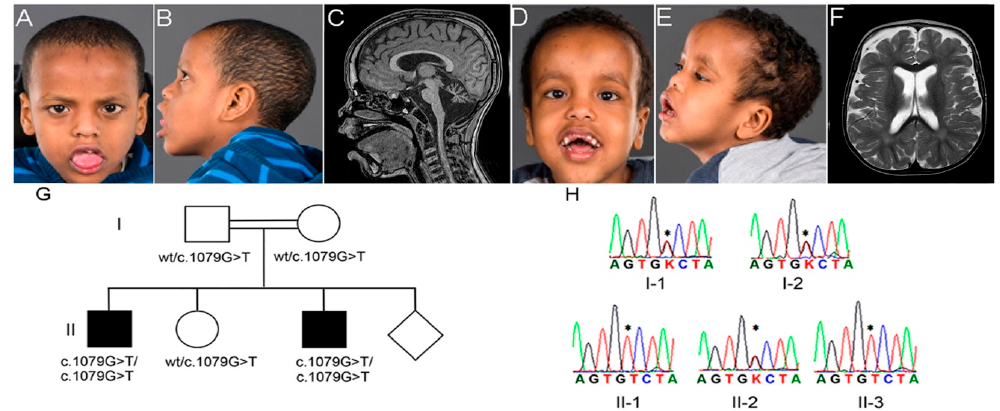
Figure 1. ( A , B ) Photographs of patient 1 taken at seven years; and ( C ) cerebral magnetic resonance imaging (MRI) with T1 sagittal midline-view of patient 1 at nine years; ( D , E ) Photographs of patient 2 taken at five years; and ( F ) MRI with T2 axial view at the level of centrum semiovale of patient 2 at 14 months; ( G ) Family pedigree with segregation of the PIGT c.1079G>T; and ( H ) chromatograms showing the Sanger sequencing of the PIGT c.1079G>T in the family members. Both patients had a high anterior hairline, a high and broad forehead with frontal bossing, bitemporal narrowing, a short nose with anteverted nares and a depressed nasal bridge, a short philtrum, a tented lip, and a wide, open mouth with sagging of the lower jaw, consistent with hypotonia. Note hyperplastic gingiva, widely spaced and irregularly shaped and sized teeth. Some teeth were missing due to falls ( D ); The ears were low-set in patient 2 ( D ). Both patients had bilateral esotropia, most notable in patient 2 ( D ); On MRI, cerebellar atrophy, particularly of the vermis, was evident in both patients. The atrophic process also caused a prominent concavity of the tegmental part of the brain stem in patient 1 ( C ); There was widening of the subarachnoidal spaces, especially frontally, as shown in patient 2 ( F ); The PIGT c.1079G>T segregated with the clinical syndrome, as the two affected brothers were homozygous (II-1 and II-3); and the healthy parents and sister were heterozygous (I-1, I-2, and II-2); wt, wild type ( G ). Chromatograms of the Sanger sequencing, showing the homozygous PIGT c.1079G>T variant in the two affected brothers and the heterozygous variant in the healthy parents and the sister. “*” = c.1079G>T; K = G or T ( H